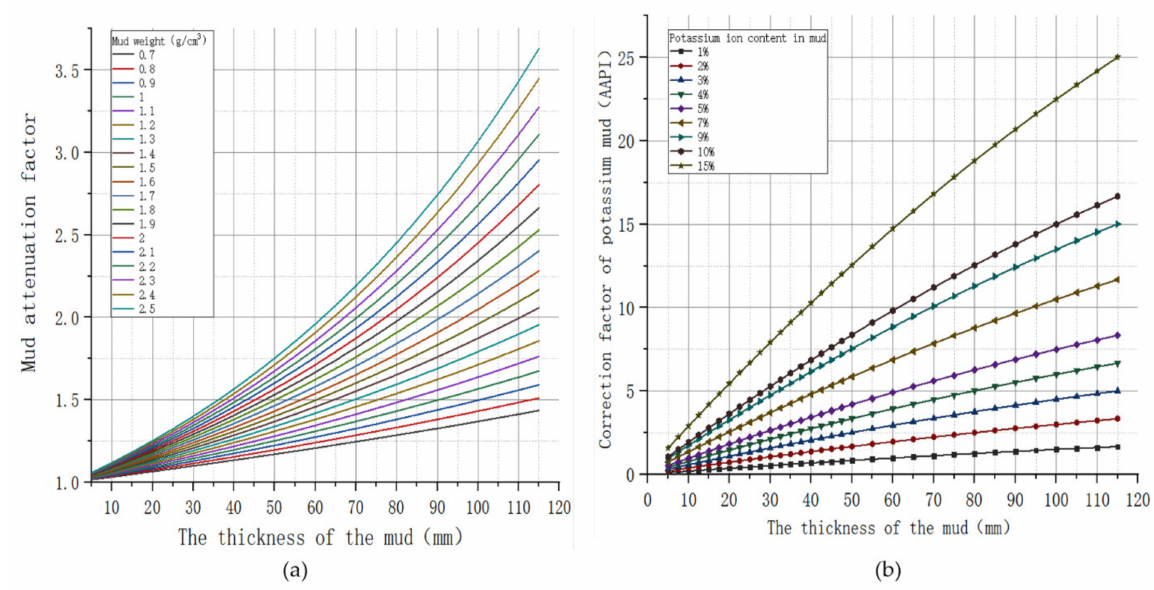
Figure 3. ( a ) Gamma mud gravity correction; ( b ) Gamma correction pattern of potassium-based